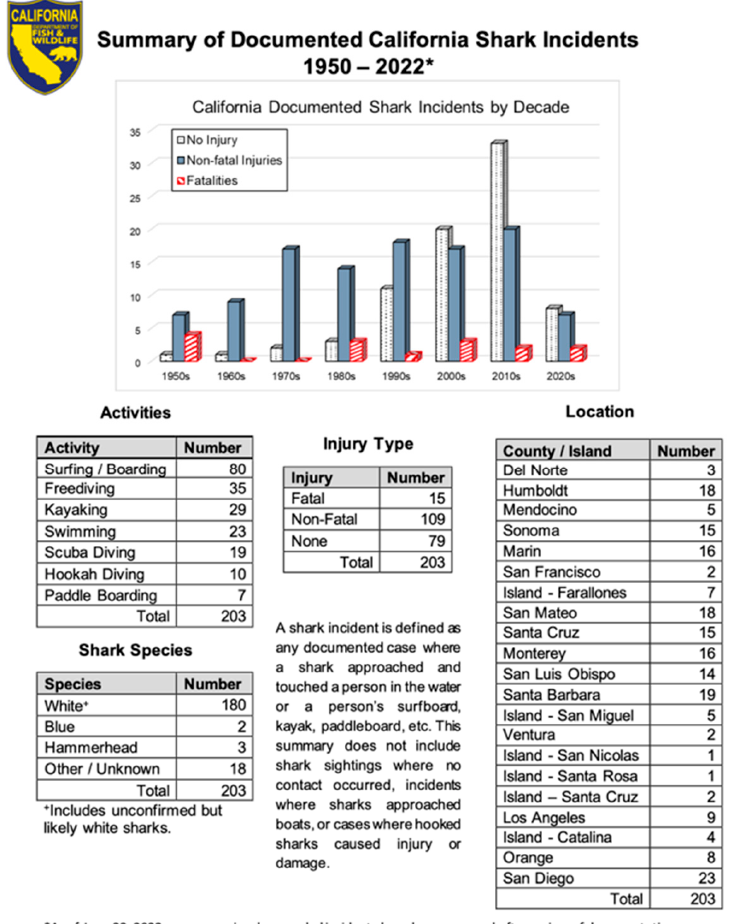
Figure 1. State of California Report on Shark Incidents.